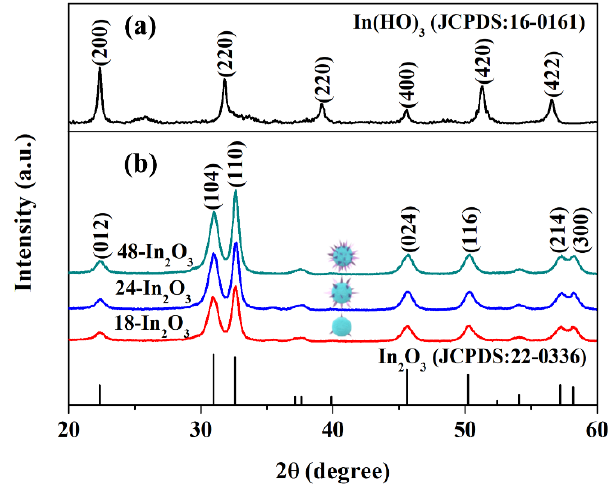
Figure 1. XRD pattern of ( a ) In(OH) 3 precursor and ( b ) porous In 2 O 3 samples. Table 1. Structural parameters of the porous In 2 O 3 samples. Table 1. Structural parameters of the porous In